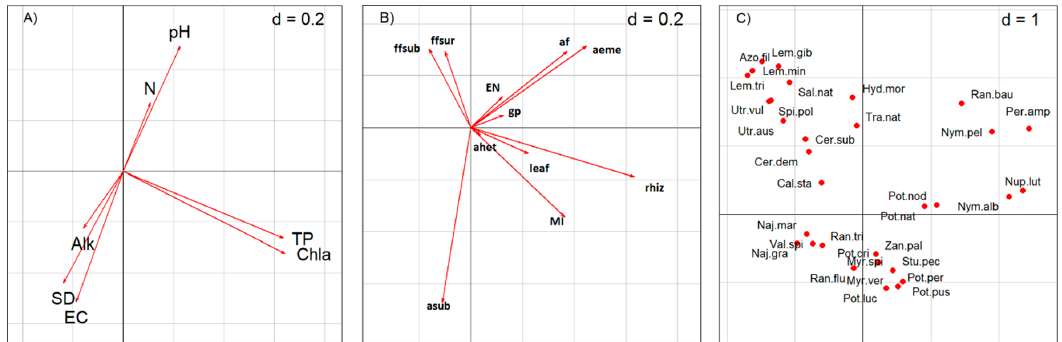
Figure 2. Results of the first two axes of RLQ analysis: ( A ) Coefficients for the environmental variables; ( B ) coefficients for the traits; and ( C ) scores of species. The ‘d’ values give the grid size for scale comparison across the three figures. Species abbreviations are given in Table 2. Trait abbreviations are given in Table 3.